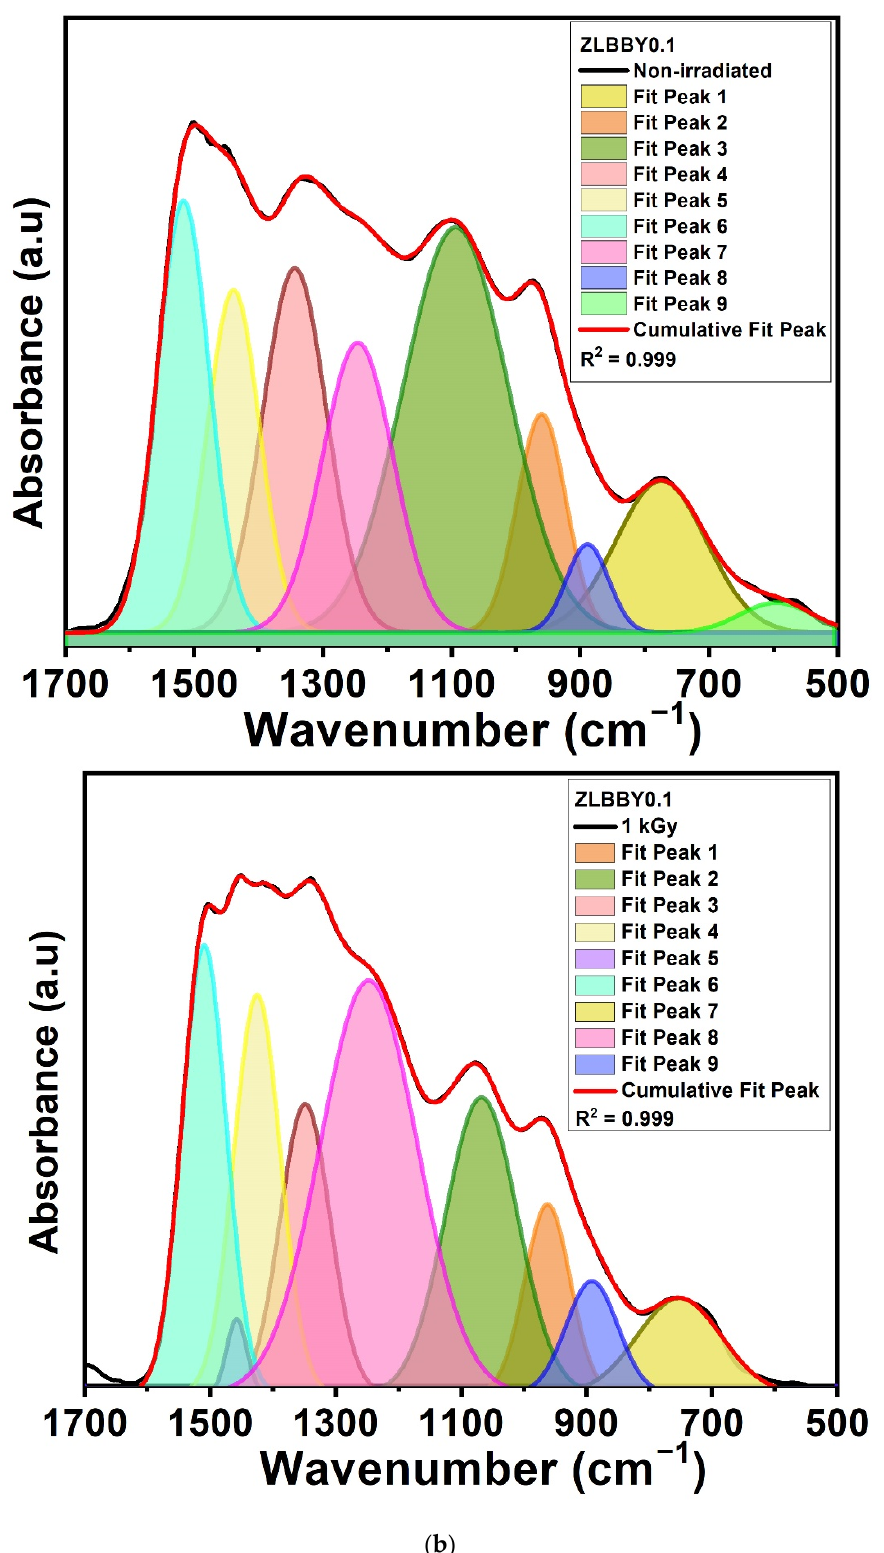
Figure 3. ( a ) Stacked FTIR profiles. The inset represents the overlaid FTIR profiles of the non- irradiated and the 1 kGy 𝛾 − irradiated ZLBBY0.1 glasses between 500 and 1700 cm − 1 . ( b ) Deconvoluted FTIR spectra of the non-irradiated and the 1 kGy 𝛾 − irradiated ZLBBY0.1 glasses between 500 and 1700 cm − 1 .